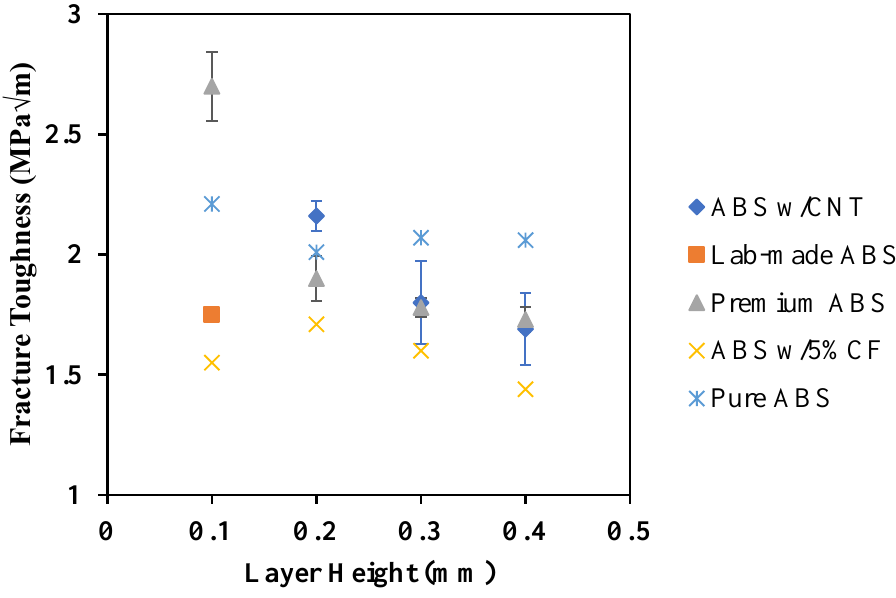
Figure 19. Fracture toughness as a function of layer height.